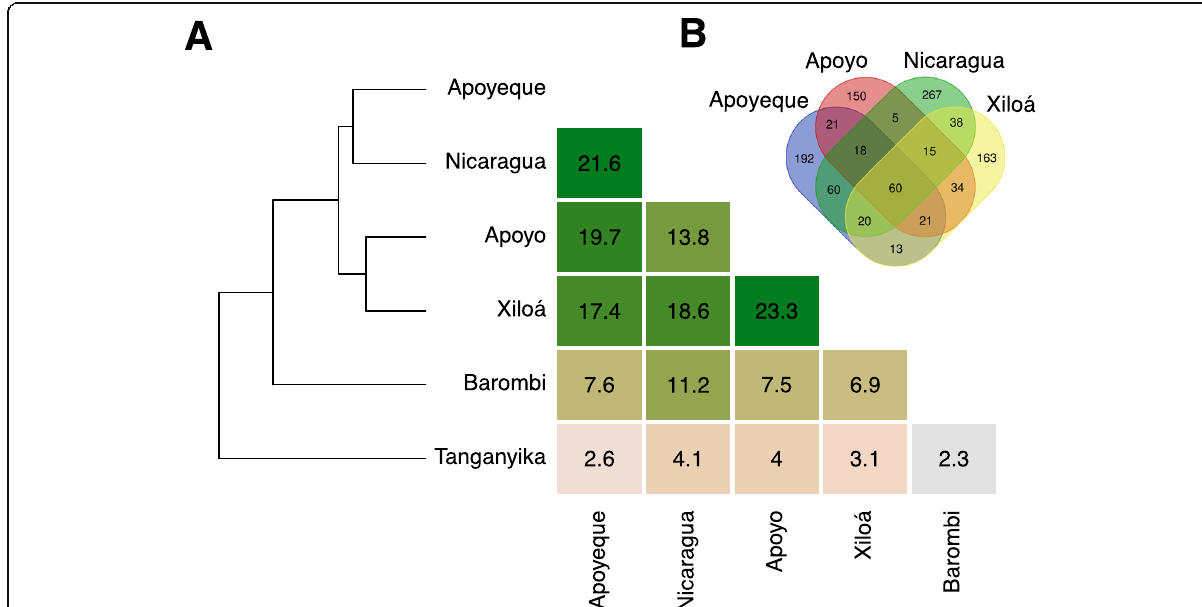
Fig. 2 Distances among lake networks estimated by a Jaccard similarity index. a Heatmap of distance matrix values as proportion of shared OTU pairwise associations (i.e. edges) among lake networks and corresponding dendrogram. b The Venn diagram shows number of shared and unique associations among the four American lake